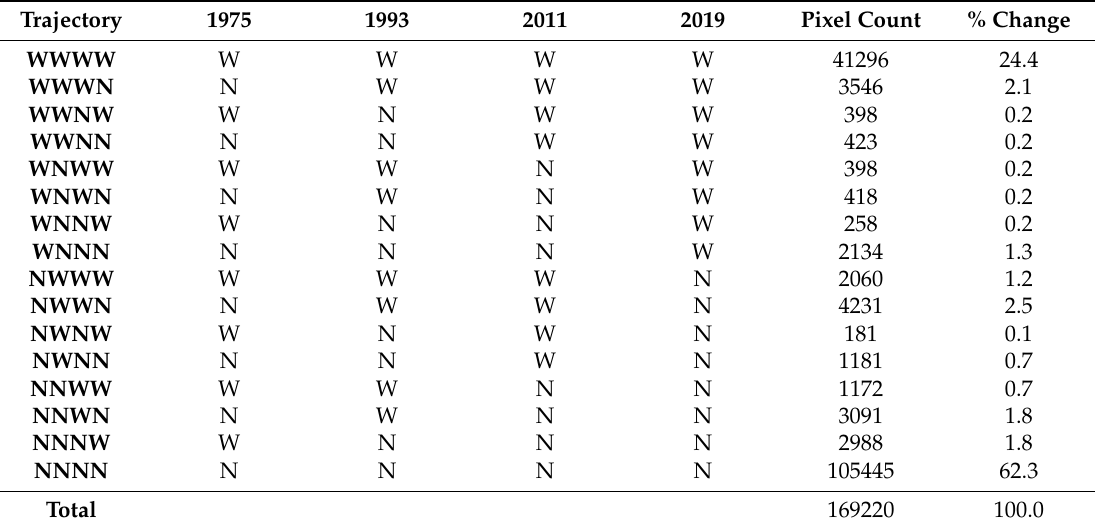
Table 2. SVM classifier change trajectory pixel counts and percent change with explanation of each change trajectory. Woody is “W” and non-woody is “N”.